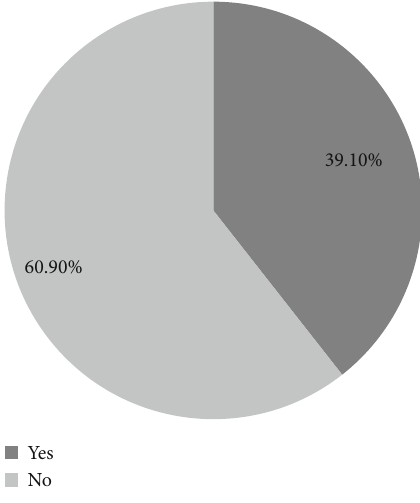
Figure 1: Prevalence of sleep quality using the Pittsburgh Sleep Quality Index (PSQI) ( n = 514